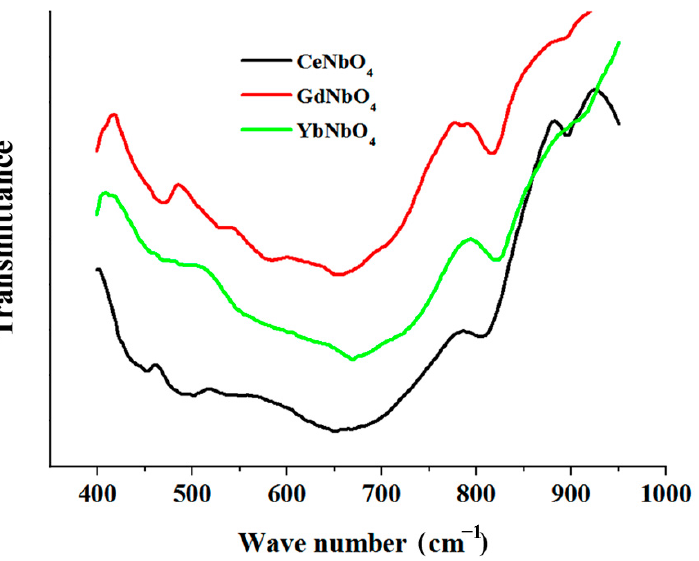
Figure 11. Infra-red spectra of the heterovalent ionic substitution reaction products formed by the interaction of the LiNbO 3 powders with molten LiCl-LnCl 3 (Ln = Ce, Gd, Yb) mixtures at 700 ° С .